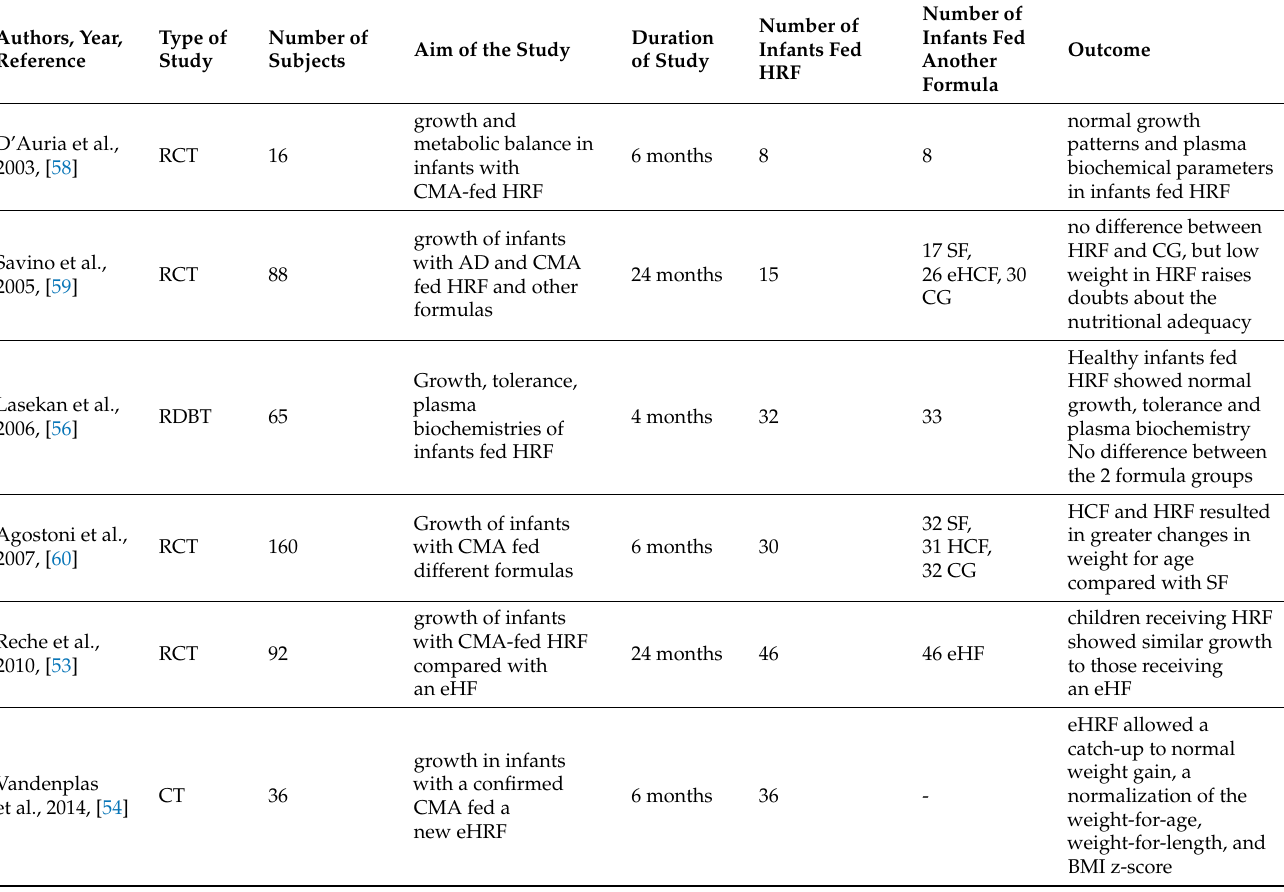
Table 2. Main studies evaluating growth while feeding